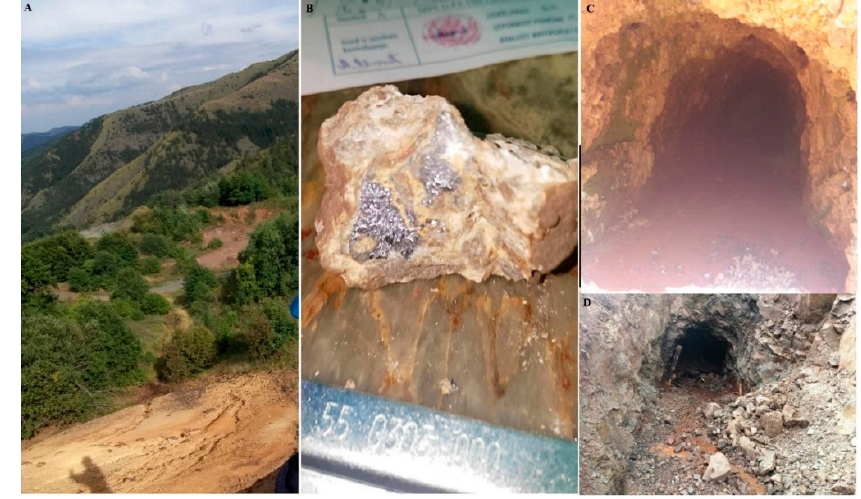
Figure 7. ( A ) Rai č eva gora; ( B ) antimony ore sample from the site; ( C , D ) mine shafts. Figure 7. ( A ) Raiˇceva gora; ( B ) antimony ore sample from the site; ( C , D ) mine